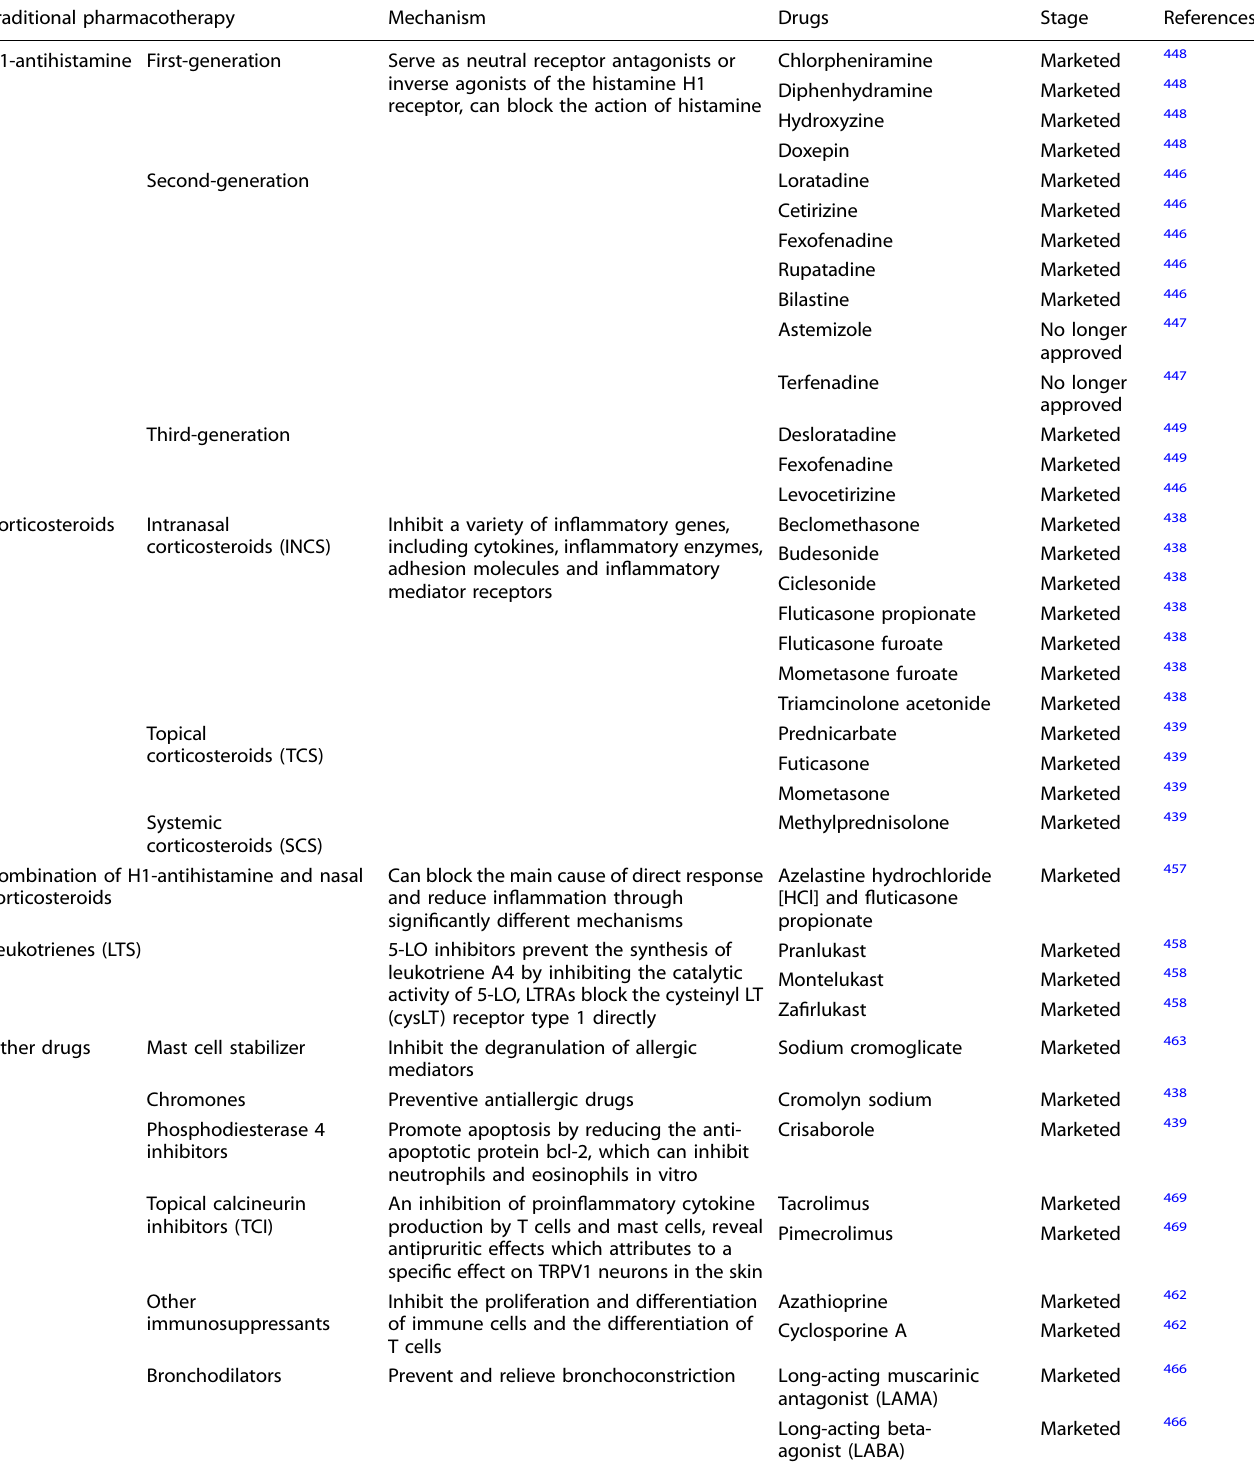
Table 2. Different Traditional pharmacotherapies and their mechanism of action and clinical application of drugs Traditional